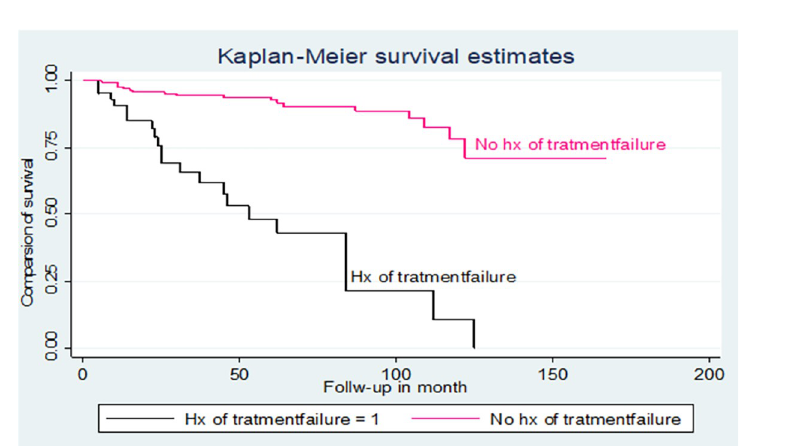
Fig 5. Kaplan-Meier of survival curve of among TB and HIV co-infected children by treatment failure in northwest Ethiopia hospitals, 2021.